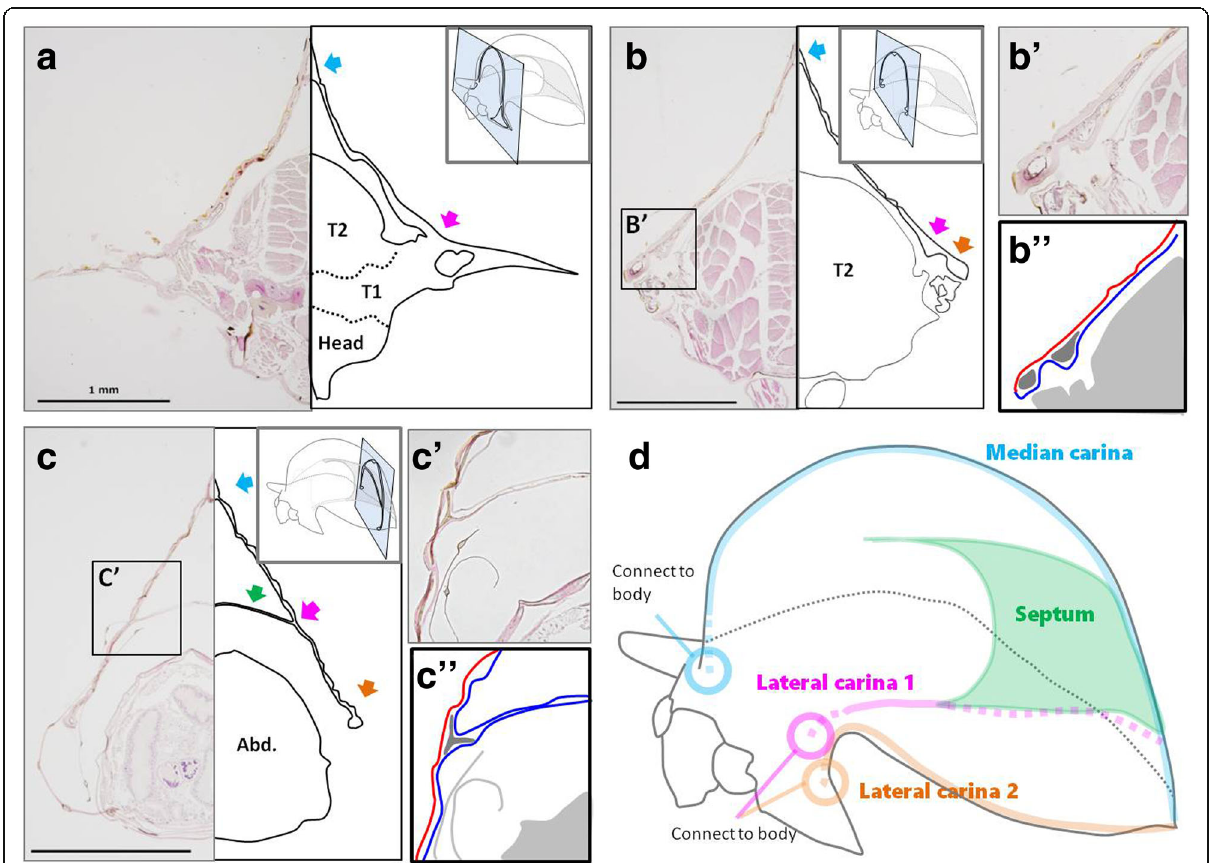
Fig. 3 Structure of adult helmet of Antianthe expansa . a - c Frontal section of adult Antianthe expansa . a Frontal section at lateral projection. A connection between lateral carina 1 (pink arrow) and the body is clearly recognizable. There is a tubular structure at the top of the helmet known as the median carina (blue arrow). b Frontal section at middle mesothorax. Note that the helmet and body are not connected. There are two tubular lateral carinae on each side of the helmet (pink and orange arrow). B ′ ) Magnified image of lateral carinae which have a thicker cuticle. Also, it can be clearly seen that the helmet is double layered. B ″ ) Schematic drawing of B ′ . Red and blue line indicate upper and lower layer, respectively. Dark gray indicates inner space of lateral carinae. c Frontal section at abdomen. The septum (green arrow) bridges both sides of